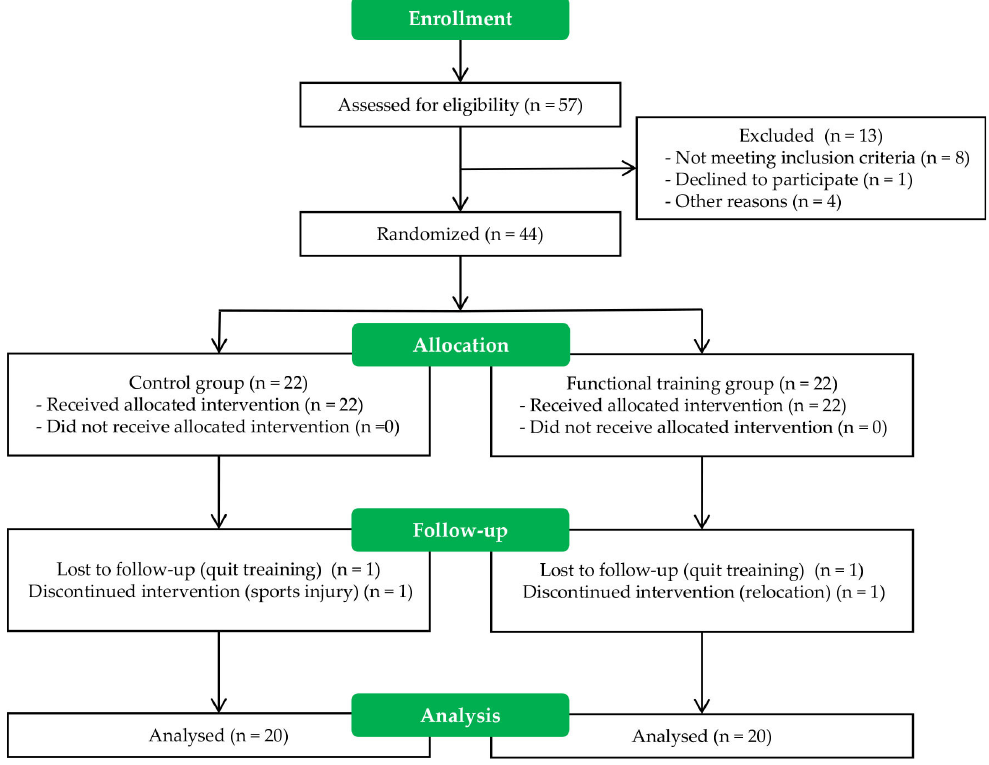
Figure 1. CONSORT flow diagram.